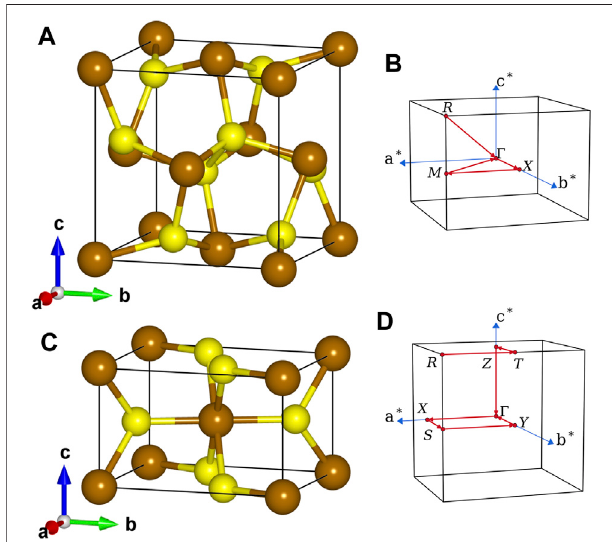
FIGURE 1 | Lattice structures (A,C) and fi rst Brillouin zones (B,D) of pyrite (upper) and marcasite (lower) phases of FeS 2 . Brown and yellow spheres represent Fe and S atoms,